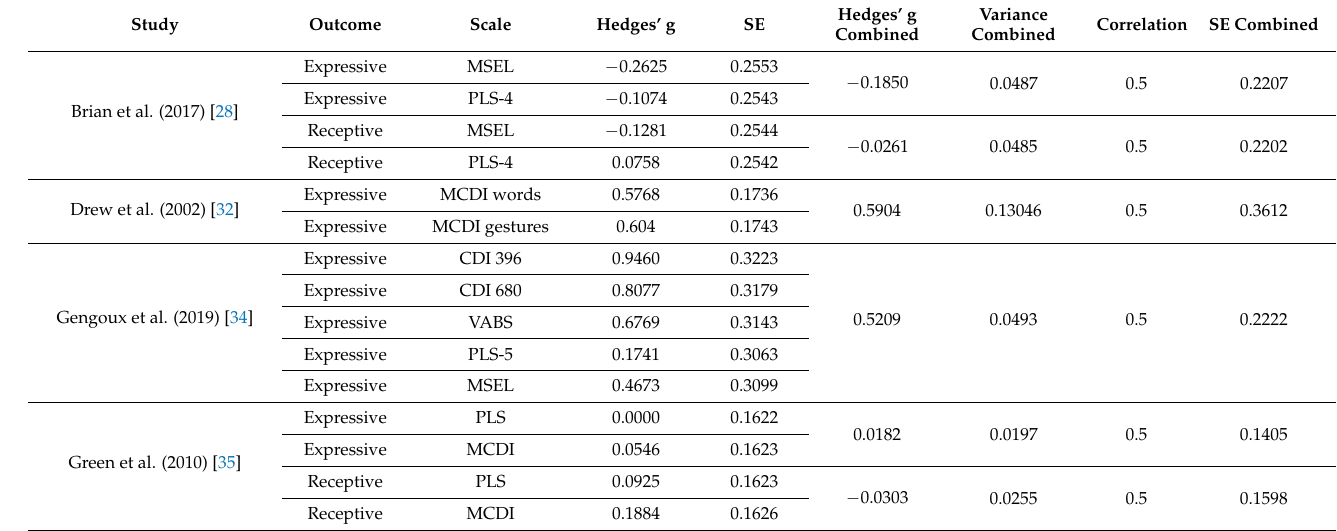
indicates Scales of Independent Behaviour scale. Table A2. List of combined variables for which there were multiple measurements per